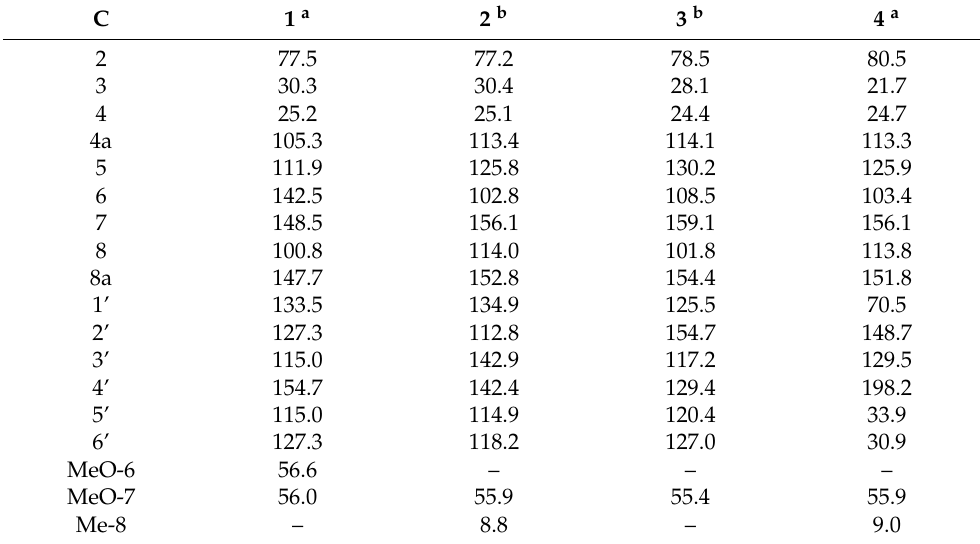
Table 2. 13 C-NMR data (CDCl 3 ) of compounds 1 – 4 . Chemical shifts δ in